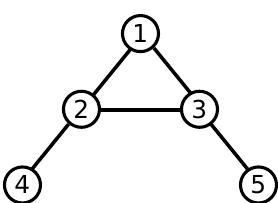
Figure 3. Five UAVs and their undirected communication links. The virtual leader is not shown here. All UAVs have access to the virtual leader’s trajectory